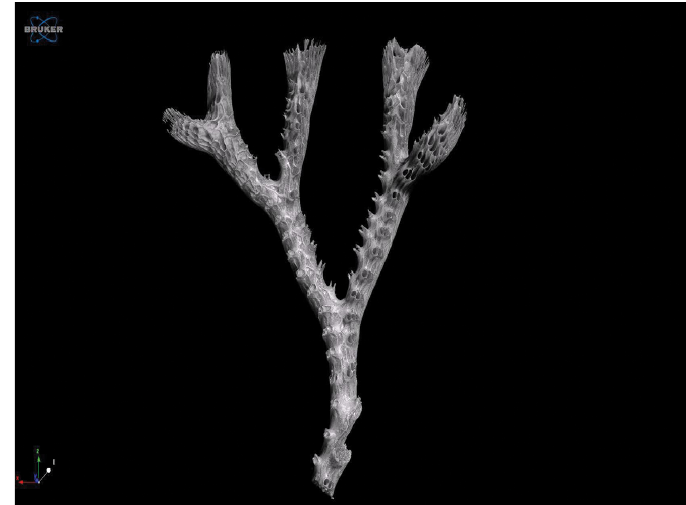
Figure 13. Video of the 3D-model of Idmidronea cf. obtecta Borg, 1944 (MNA 9890). Height and width of the colony are respectively ~20.4 mm and ~17.5 mm.